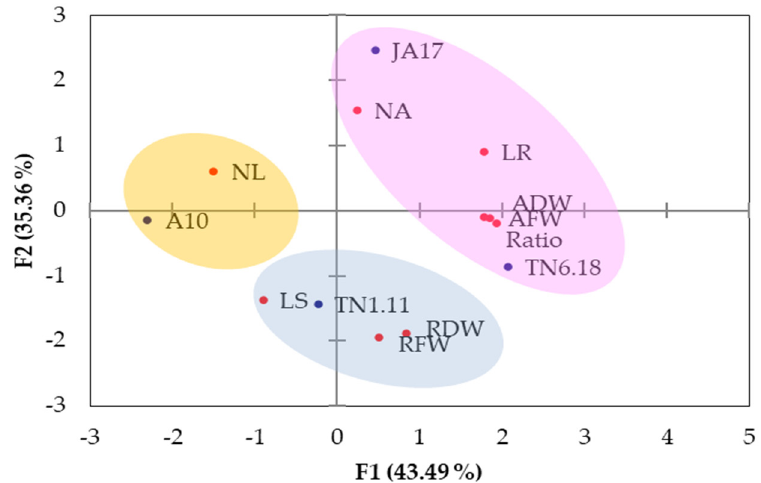
Figure 5. Distribution of the studied lines in the plan (1–2) of the principal components analysis based on drought sensitivity indices (DSI). Number of axes (NA), length of stems (LS, cm), number of leaves (NL), aerial fresh weight (AFW), aerial dry weight (ADW), length of roots (LR), root fresh weight (RFW), root dry weight (RDW), and aerial dry weight (RDW/ADW) ratio were assessed.